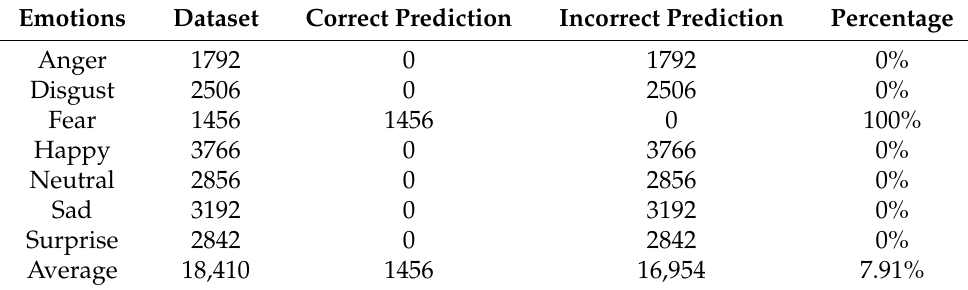
Table 9. Test result with prediction detail of Model 2 after 10